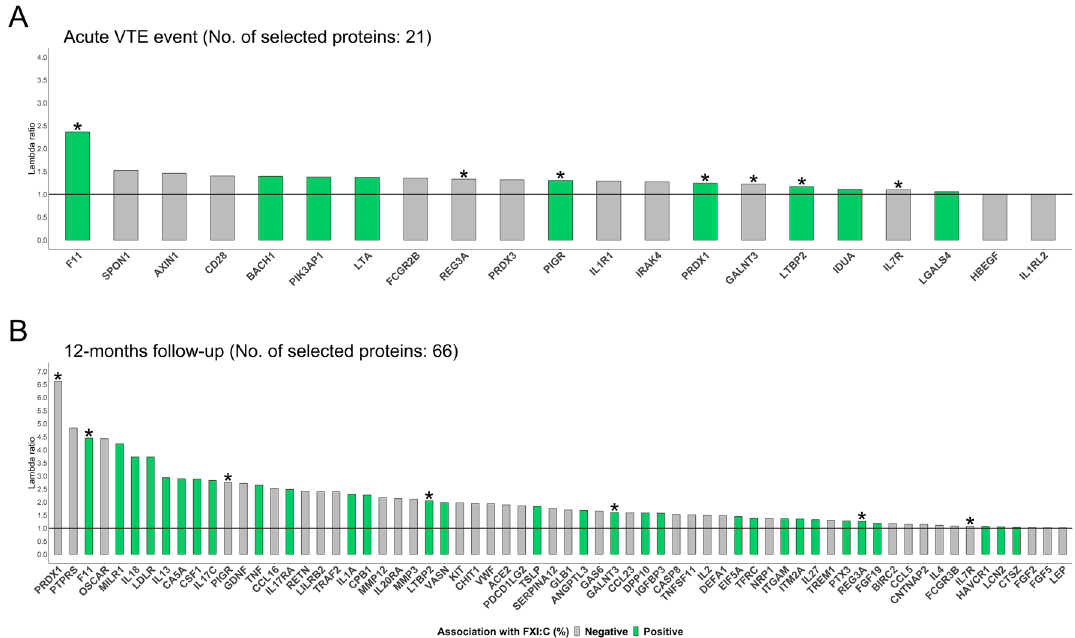
Figure 2. Shared and specific FXI:C-related proteins of the acute VTE event and 12 months after the acute event. This figure displays the shared and specific proteins selected by LASSO-regularized regression models. Panels A and B depict the effect size and association with FXI:C at the acute VTE event and 12 months follow-up, respectively. Proteins selected in both models were shown indicated with a symbol (*).